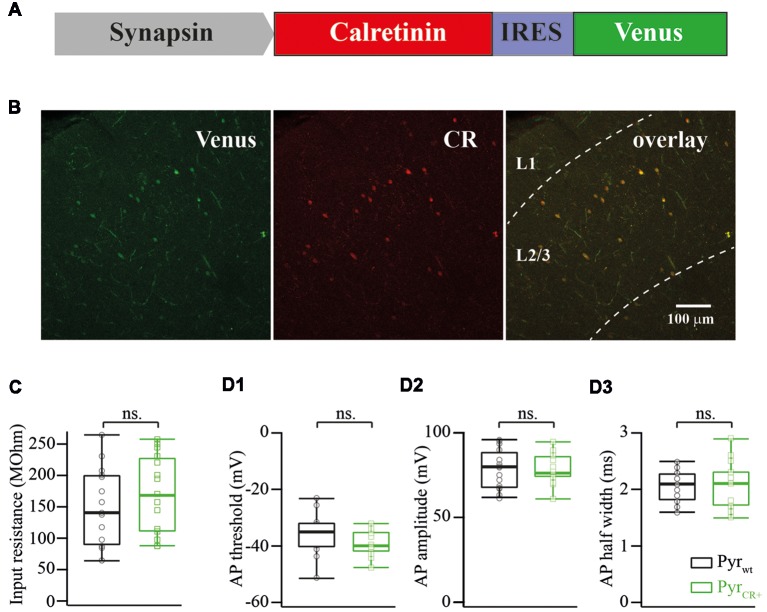
(A) Schematic drawing of a viral cassette carrying calretinin and Venus. (B) Fluorescent images of a fixed cortical slice infected with AAV carrying calretinin and Venus. Left panel, Venus fluorescence; central panel, immunostaining against calretinin; right panel, overlay of both images. (C) Calretinin expression does not change the input resistance of layer 2/3 pyramidal cells (median WT vs. CR+: 143 vs. 173 MOhm; n = 15; p = 0.319 Mann-Whitney Test rank sum test). (D) Calretinin expression does not change the action potential (AP) properties of layer 2/3 pyramidal cells (median WT vs. CR+; n = 15 Mann-Whitney rank sum test): (D1) AP threshold −35 vs. −40 mV, p = 0.12; (D2) AP amplitude 79 vs. 76 mV, p = 0.9; (D3) AP half width 2.1 vs. 2.1, p = 0.9, ns, non-significant.